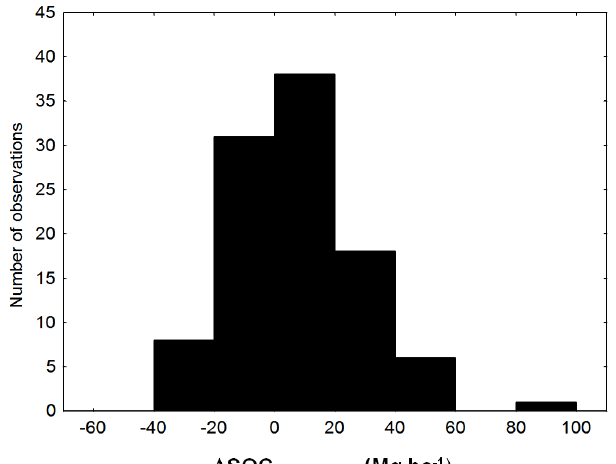
Fig. 6. Histograms of differences in carbon soil stocks between pasture soils and the carbon soil stock of native vegetation ( 1 C Bernoux-abs ) obtained by Bernoux et al. (2002).